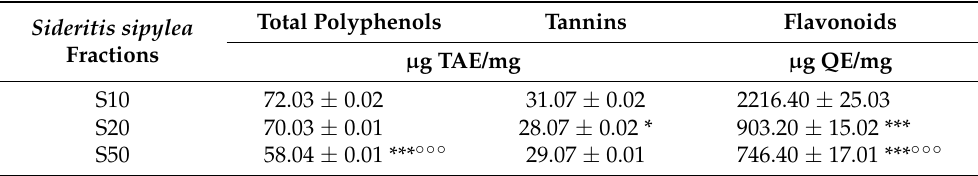
Table 1. Total amount of polyphenols, tannins, and flavonoids in S10, S20, and S50 fractions from Sideritis sipylea Boiss. Data are expressed as means ± standard error (SE) of at least two experiments and six replicates. Total Polyphenols Sideritis sipylea Fractions